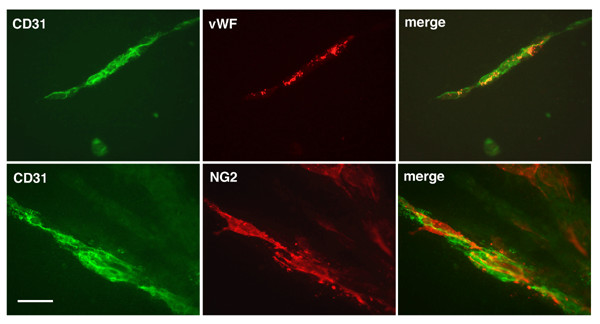
Double immunostainings of embryoid bodies sprouts for CD31, von Willebrand factor (vWF) and NG2 proteoglycan. CJ7 ES cells were allowed to differentiate in the presence of angiogenic growth factors (VEGF+FGF2) added at day 0. EBs angiogenic sprouts were analyzed at day 11 of differentiation. vWF immunoreactivity (red fluorescence) located in Weibel-Palade bodies can be observed in several sprouting CD31-positive cells (green fluorescence) (upper panels). Elongated NG2 proteoglycan-positive cells (red fluorescence) can be seen close to CD31-positive cells constituting endothelial sprouts (lower panels). Scale bar = 50 μm.